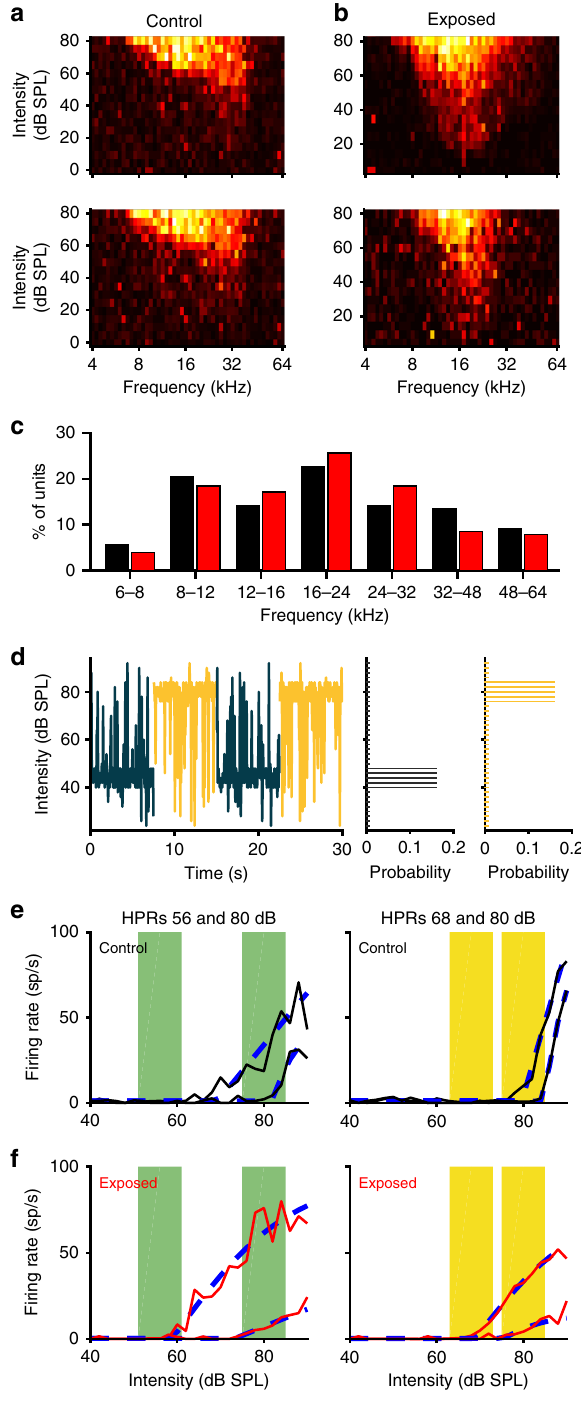
Fig. 3g, to enable a direct comparison across all HPRs. To assess whether noise exposure had a signi fi cant effect on MUC thresholds, we fi tted a repeated measures model with HPR mean and context (i.e. the mean intensity of the HPR in the other half of each switching stimulus) as continuous factors (see